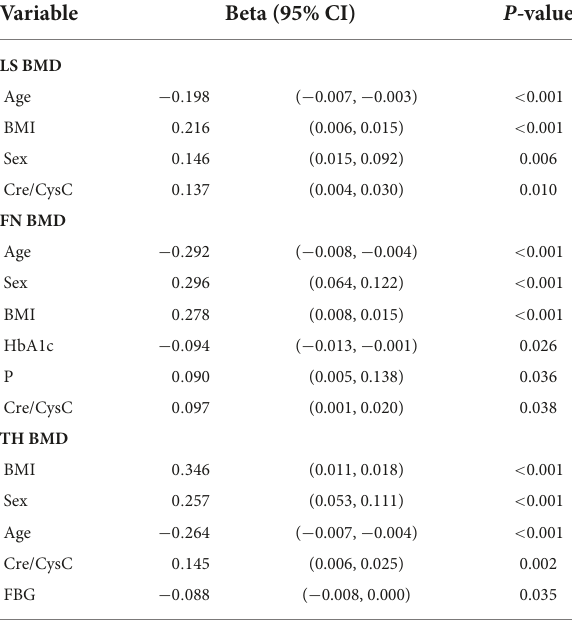
TABLE 3 Multiple stepwise linear regression analyses of variables related to the